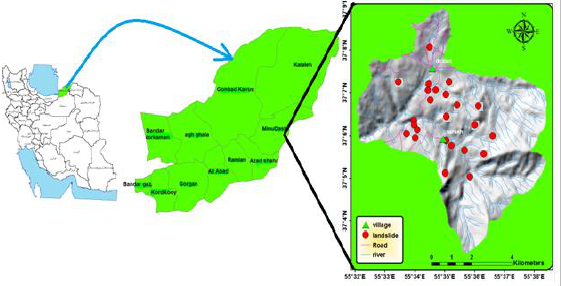
Figure 1. Location map of the study